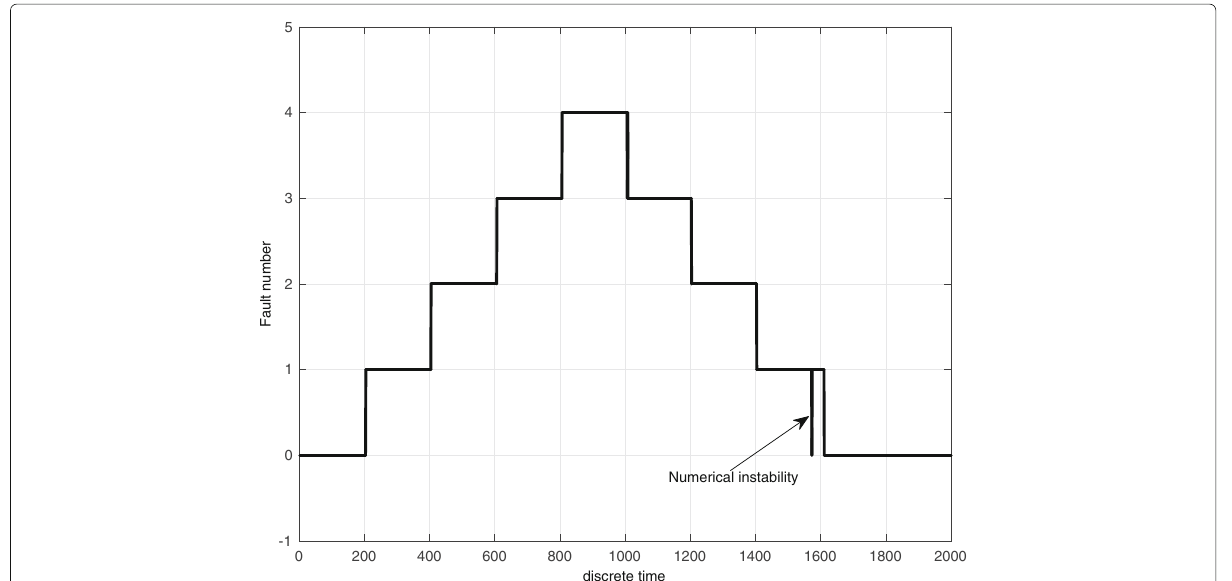
Fig. 3 Maximum a posteriori estimate of faulty condition. Vertical axis determines faulty condition. In sample 1572, there occurs a numerical instability, causing mislabeling the